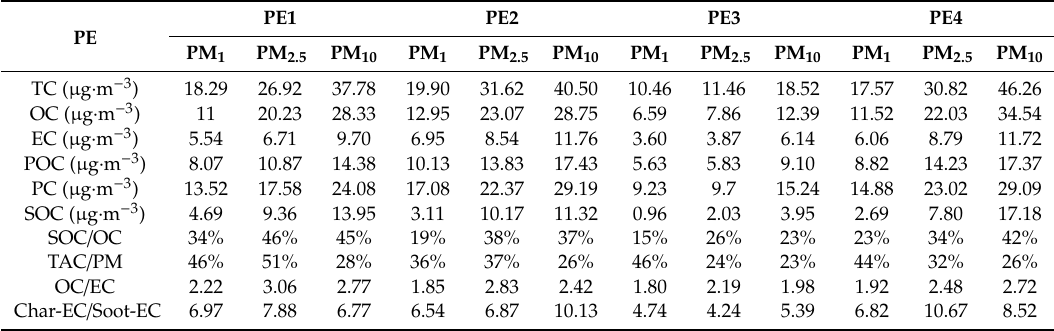
Figure 3. The mass concentration of OC and EC in PM 1 , PM 2.5 and PM 10 during the sampling days. Table 2. Concentration and range of carbonaceous components in PM 1 , PM 2.5 and PM 10 in the four PEs.